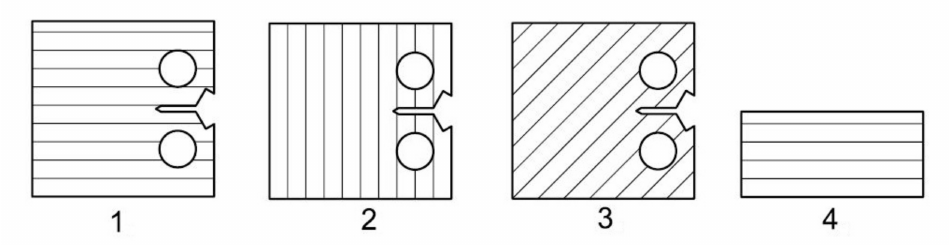
Figure 1. Sintering topology layout for all specimens: 1 = 0 ◦ ; 2 = 90 ◦ ; 3 = 45 ◦ ; 4 = twice opposite 90 ◦ .